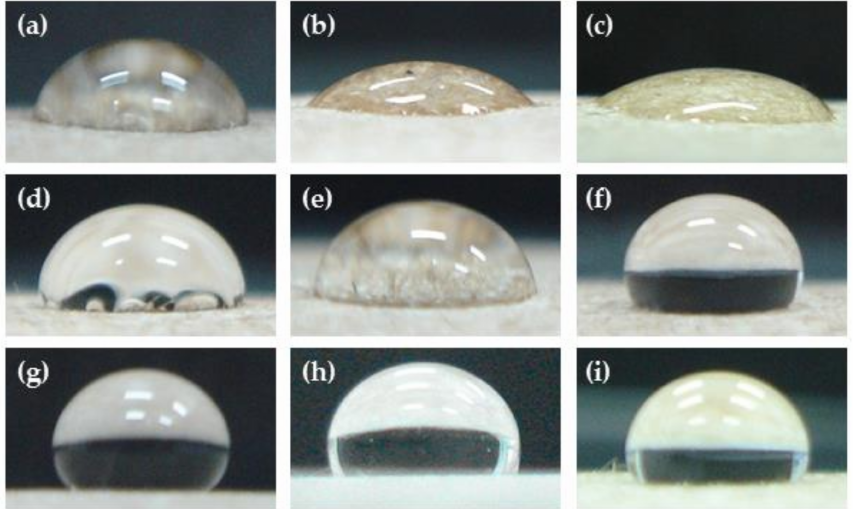
Figure 1. Effect of pressure on contact angles of water droplets placed (40 µ L) at 200 mTorr and 50 Watts for ( a ) untreated, ( b ) Ar-treated, ( c ) 20 mTorr, ( d ) 50 mTorr, ( e ) 100 mTorr, ( f ) 150 mTorr,